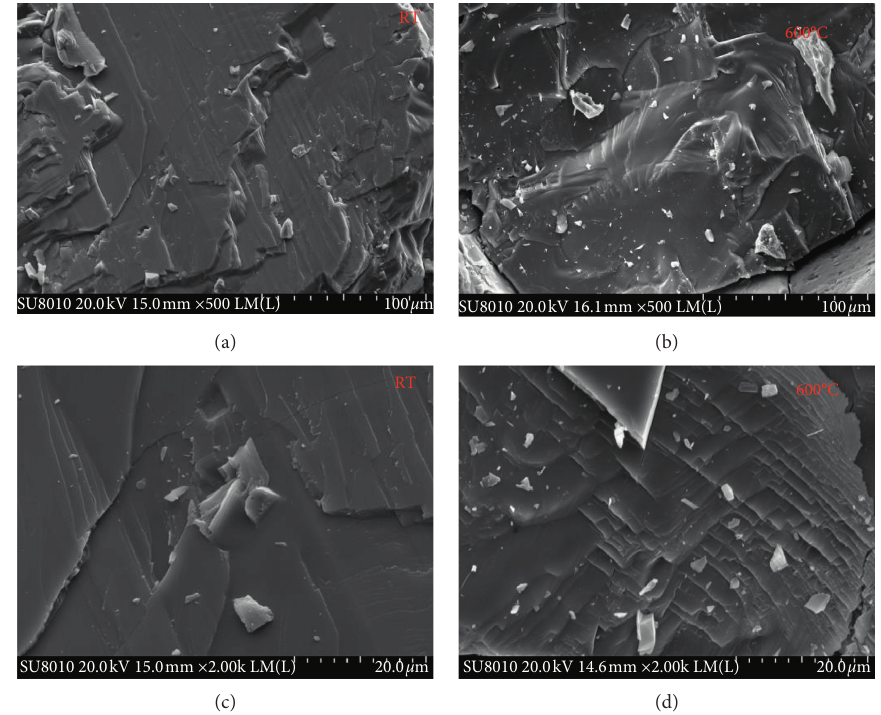
Figure 9: The untreated and heat-treated granite cleavage fracture microscopic morphology SEM images. (a, c) RT and (b, d) 600 °